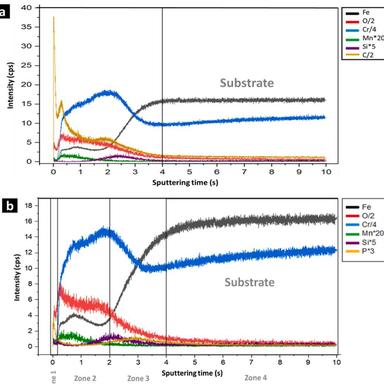
GDOES depth profile of the blank sample containing the thermal oxide film (a) and the phosphated sample (b).